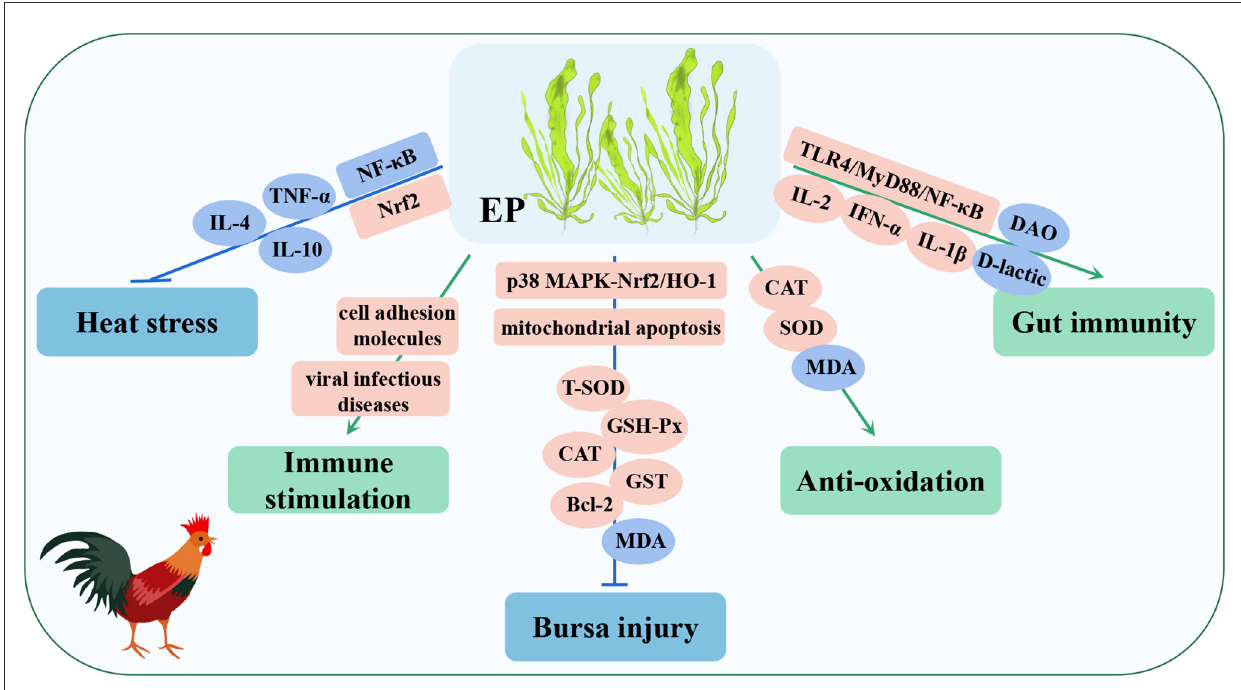
FIGURE8 Immunomodulatory and disease-resistant effects of Enteromorpha polysaccharide (EP) in poultry. Nrf2, nuclea factor erythroid-2-related factor 2; Bcl-2, B-cell lymphoma-2; GST, glutathione-S-transferase; IFN- α , interferon- α .